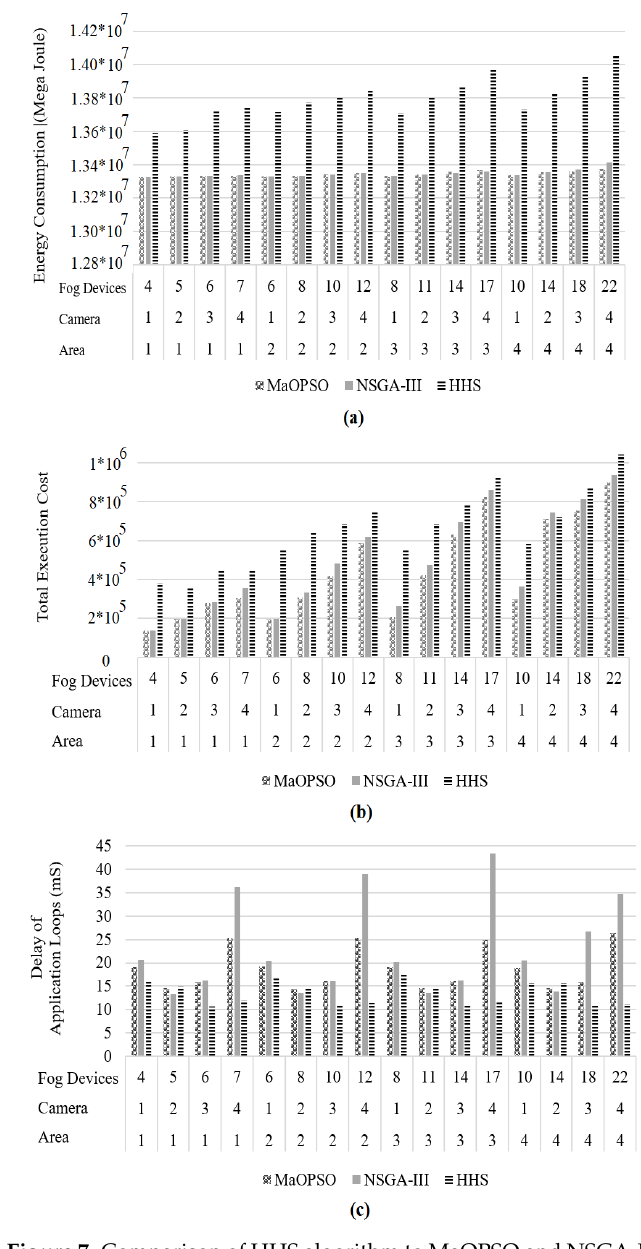
Figure 7. Comparison of HHS algorithm to MaOPSO and NSGA-III: ( a ) Energy consumption ( b ) Total execution cost, and ( c ) Delay of application